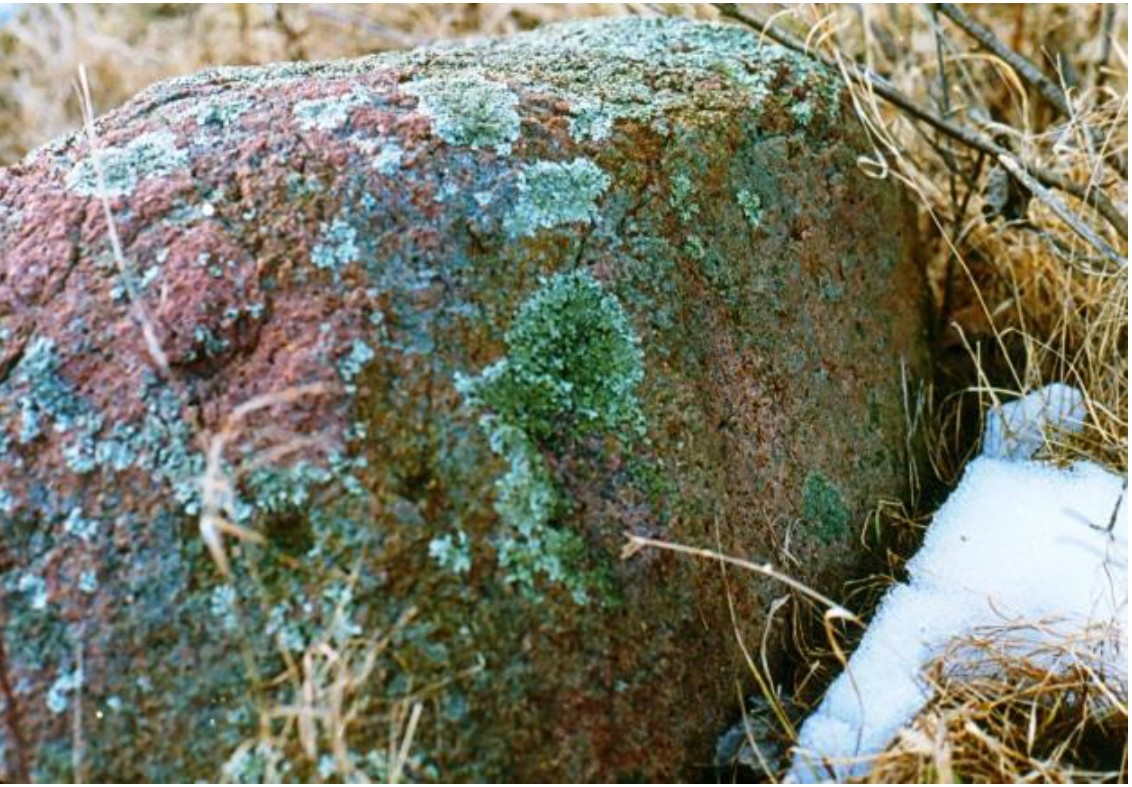
Figure 7. Photo showing the remarkable difference between the still smooth, flat base and highly weathered sides which, unlike the base, have been exposed to the long term weathering in the